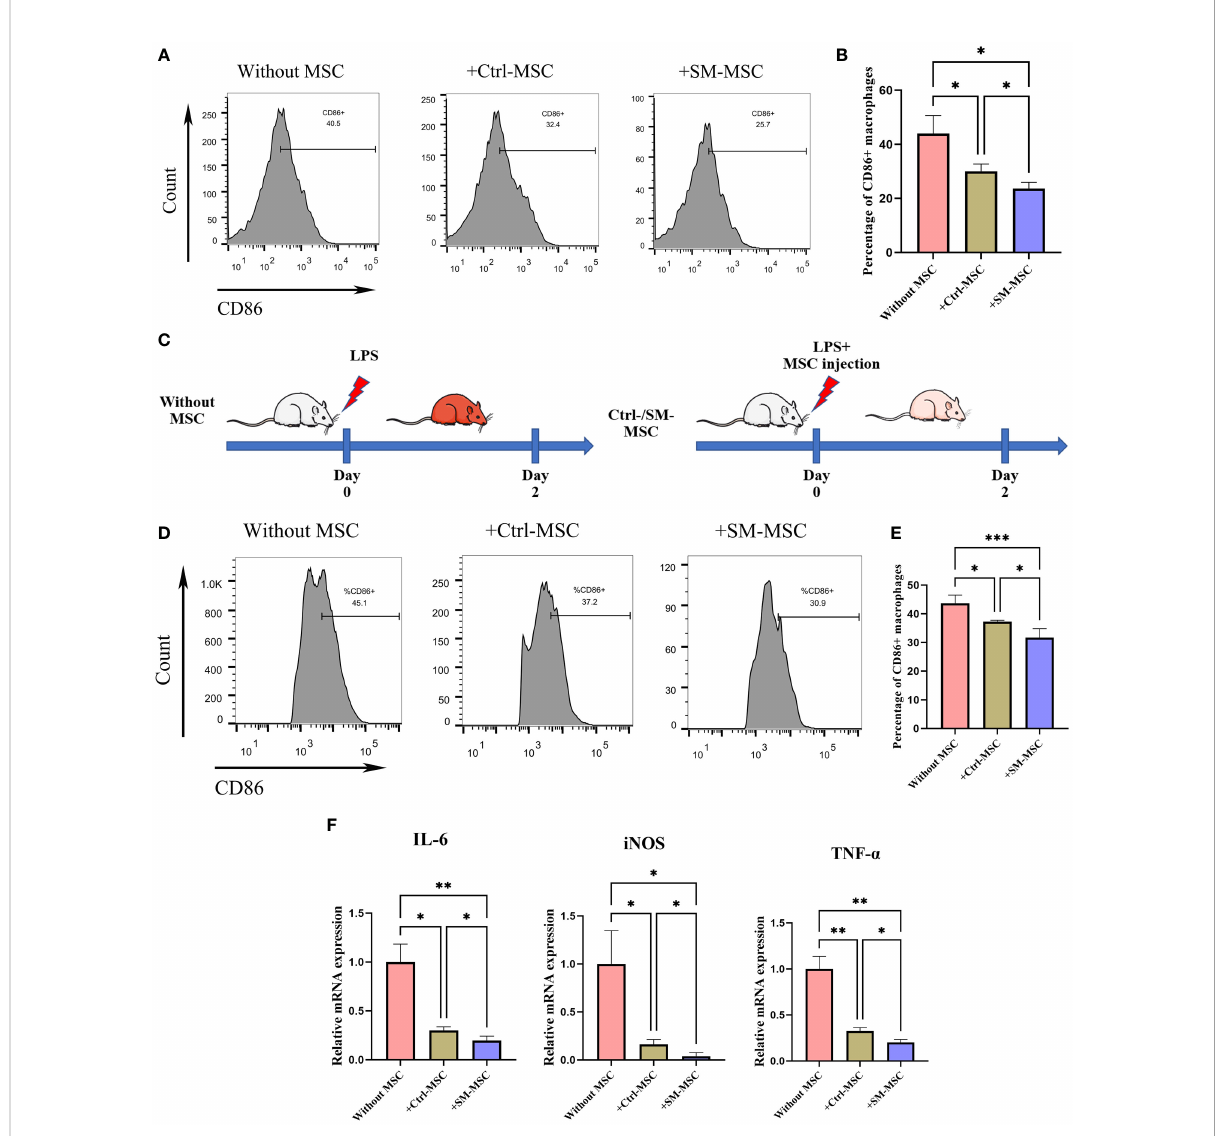
FIGURE 6 Comparison of immunosuppressive effects on activated macrophages. (A, B) Flow cytometry was adopted to analyze the proportion of CD86 positive M1 macrophages. n = 4 per group. (C) Schematic of experimental protocol for establishing LPS-induced endotoxemia model and the subsequent MSC treatment. (D, E) Flow cytometry was adopted to analyze the proportion of CD86 positive M1 peritoneal macrophages. n = 5 per group. (F) The mRNA levels of chemokines. n = 4 per group. Data are shown as mean ± SD, *P < 0.05, **P < 0.01, ***P <